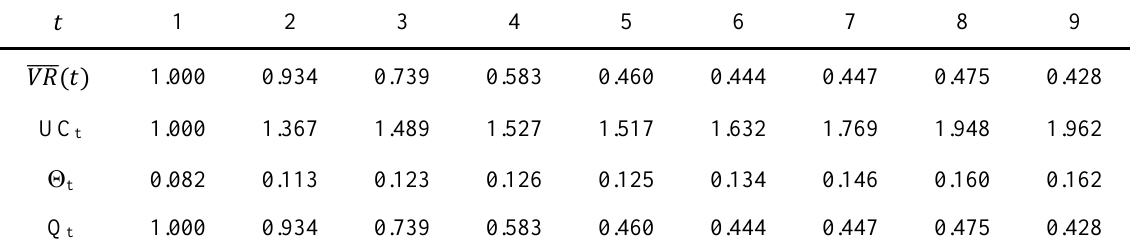
Table 4. Computing Uncertainty Coefficients and risk premiums for